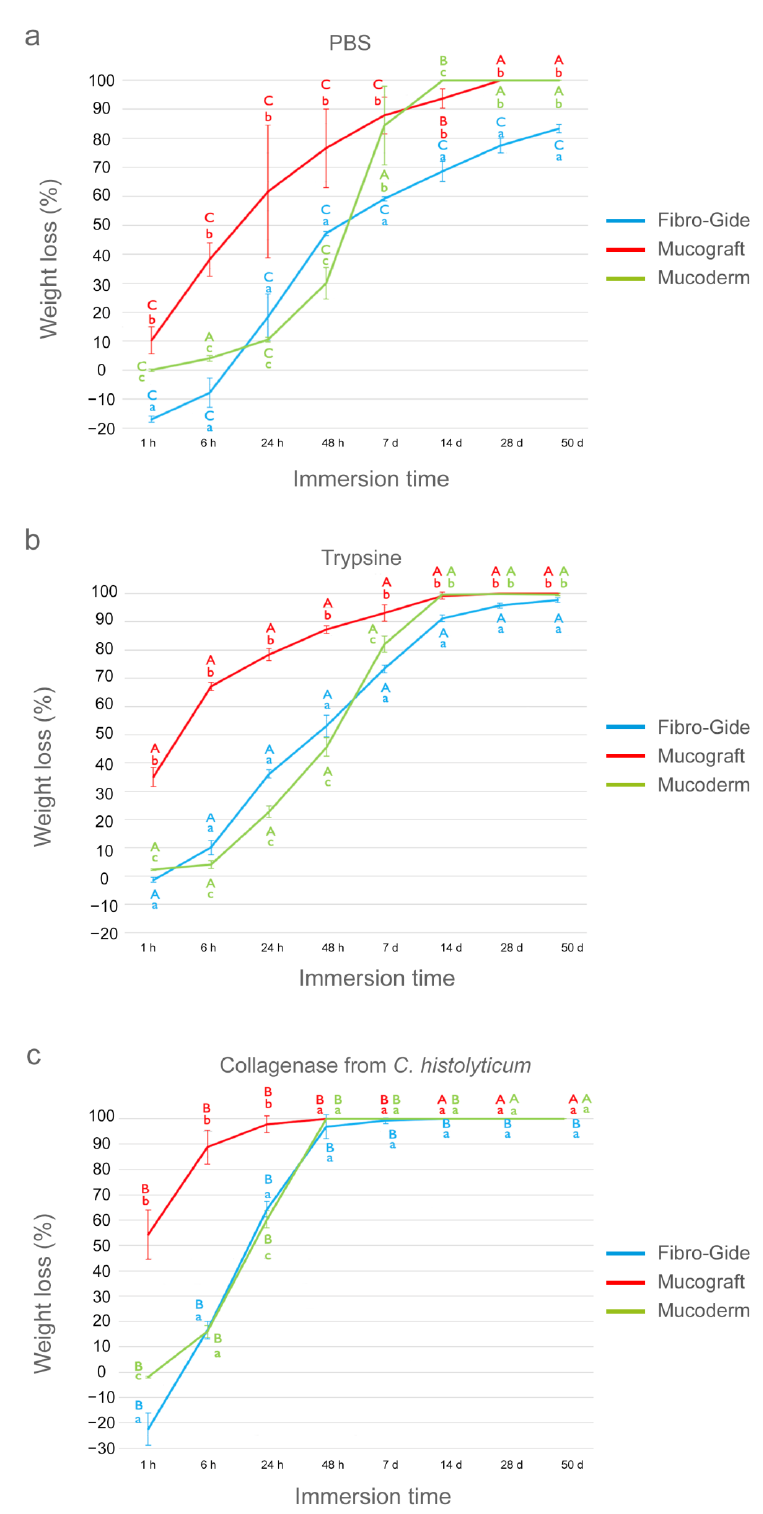
Figure 2. Percentage of weight loss in the three tested matrices after the different immersion periods of up to 50 days in: ( a ) PBS, ( b ) trypsin and ( c ) C. histolyticum collagenase. Values are shown as mean and standard deviation. Statistical significance is shown with lower-case letters for differences between matrices over the same degradation test, and with capital letters for differences between degradation tests within the same membrane. Student–Newman–Keuls tests were performed for multiple comparisons ( p <